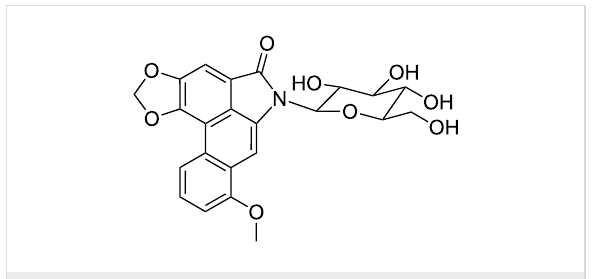
Figure 4: Structural representation of aristololactam- β -D-glucoside.